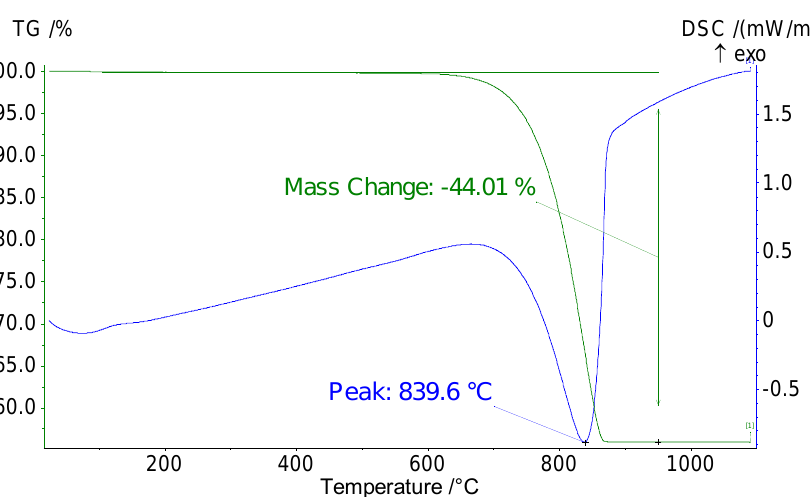
Figure 5. Thermogravimetry (TG, green line) and differential scanning calorimetry (DSC, blue line) of marble powder (M).